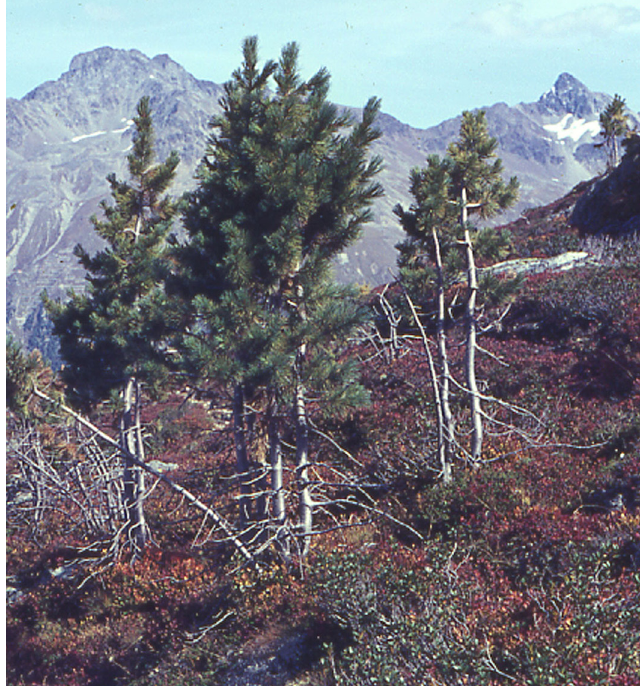
Fig. 20: Swiss stone pine cluster ( Pinus cembra ) ‘planted’ by the European nutcracker ( Caryocatactes caryocatactes ) on the northwest-facing slope of the Upper Engadine main valley at about 2200 m. The taller and older trees gradually increased snow deposition. They became infected by white snowblight ( Phacidium infestans ) and lost all their needles encased in the winter snowpack. The younger pines were completely destroyed. Photo taken by the author, September